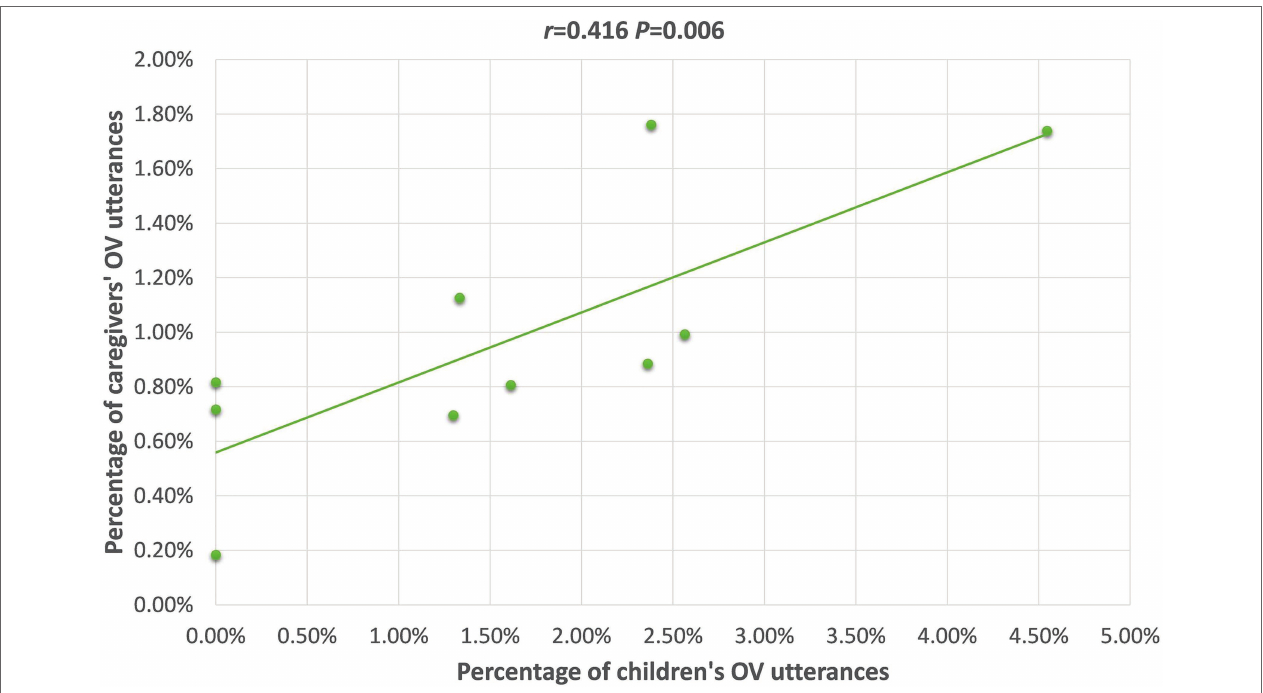
FIGURE 3 | Scatterplot of 26 m TD children’s and caregivers’ OV